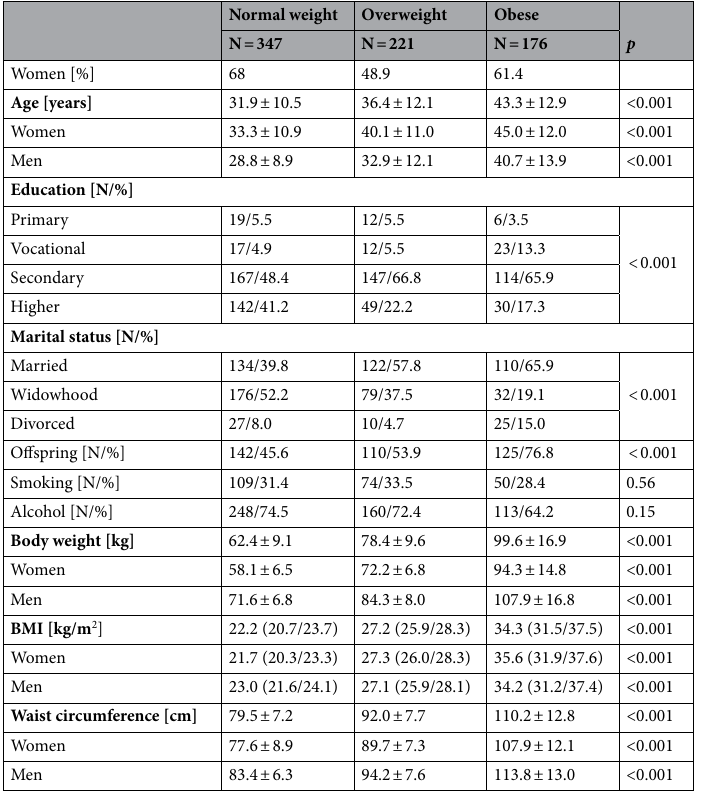
Table 1. Characteristics of the study group according to gender and weight status. Mean ± standard deviation or median (lower and upper